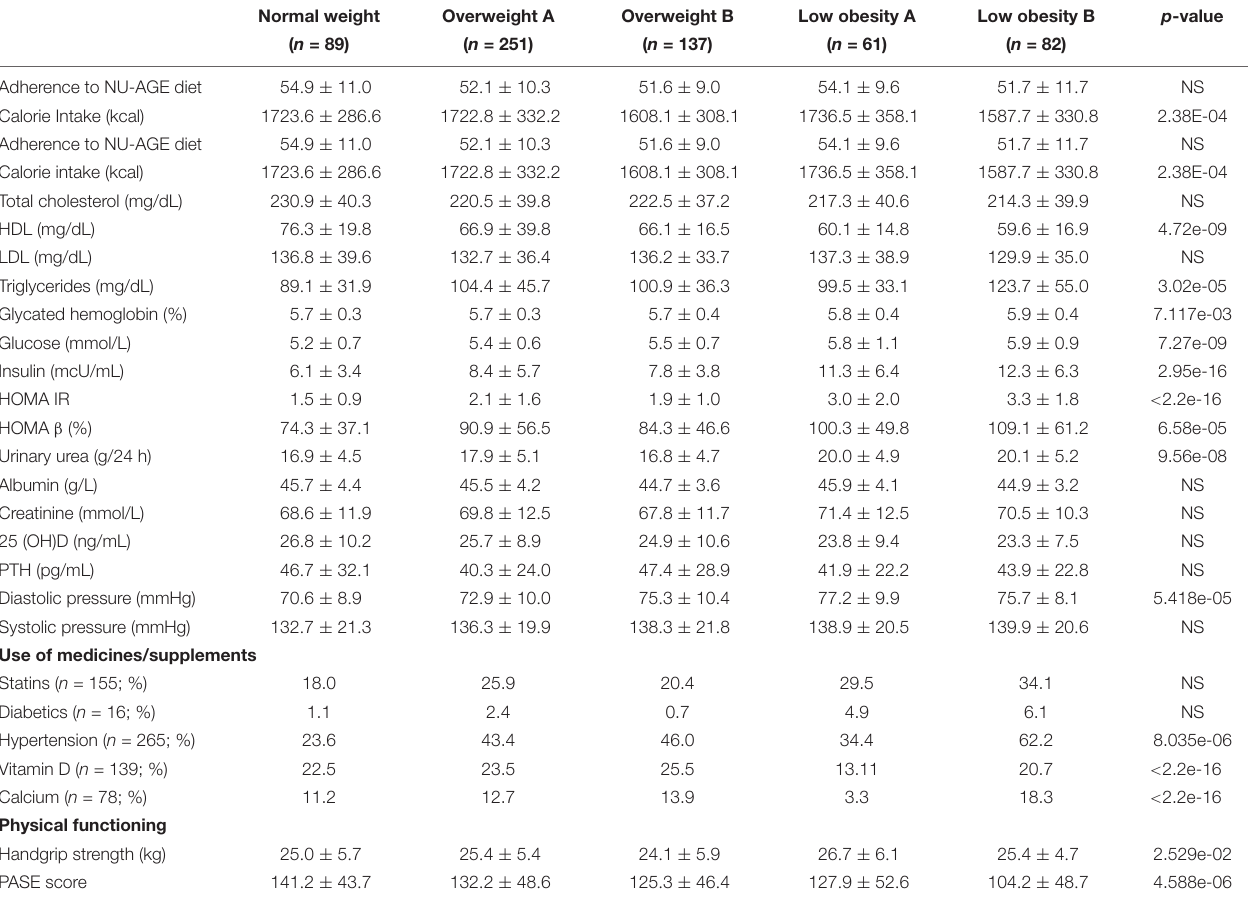
TABLE 4A | Metabolic profile across the five body composition clusters in women. Normal weight Overweight A Overweight B Low obesity A Low obesity